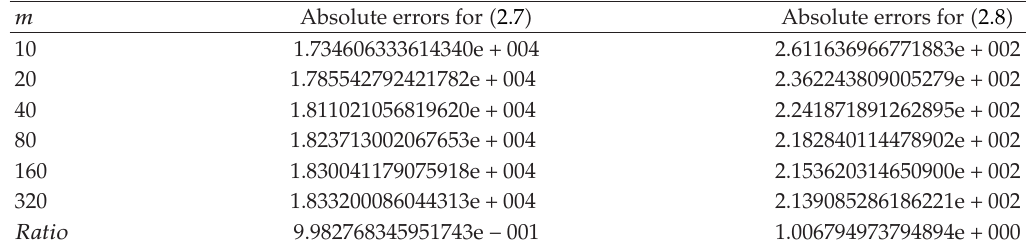
Table 2: The mid-point rule for (cid:6) 2.7 (cid:7) and (cid:6) 2.8 (cid:7) .